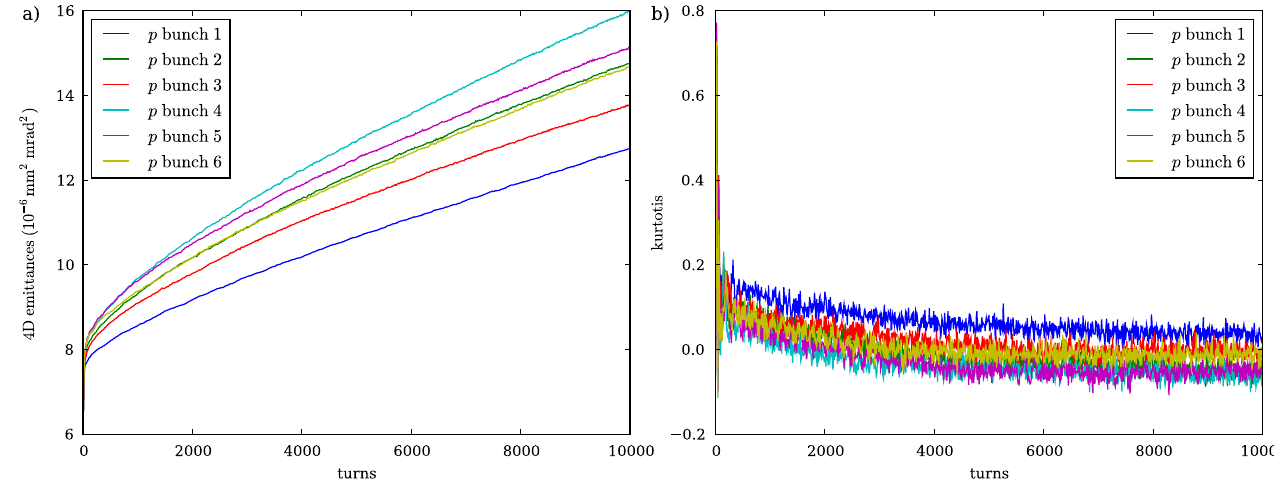
FIG. 16. (Color) In a six-on-six bunch Tevatron run with 8 : 8 (cid:2) 10 11 particles/bunch, with both nearest upstream and downstream parasitic IPs artificially widened: (a) The 4D emittance of each of the six bunches as a function of turn; (b) the y kurtosis of the six bunches as a function of turn.